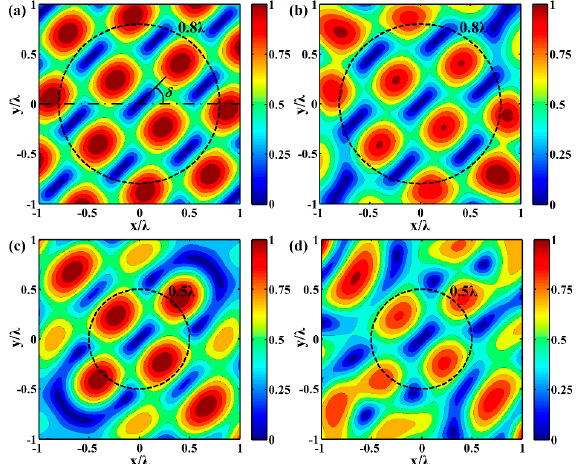
Figure 2. ( a ) The desired acoustic pressure field for manipulating non-spherical micro-particle. The black dashed line indicates the boundary of acoustic field to be synthesized. Desired fields are synthesized within different regions: ( b ) 0.8 λ with the truncated order M = 6 and thirteen transducers; ( c ) 0.5 λ with the truncated order M = 4 and thirteen transducers; and, ( d ) 0.5 λ with the truncated order M = 4 and nine transducers.